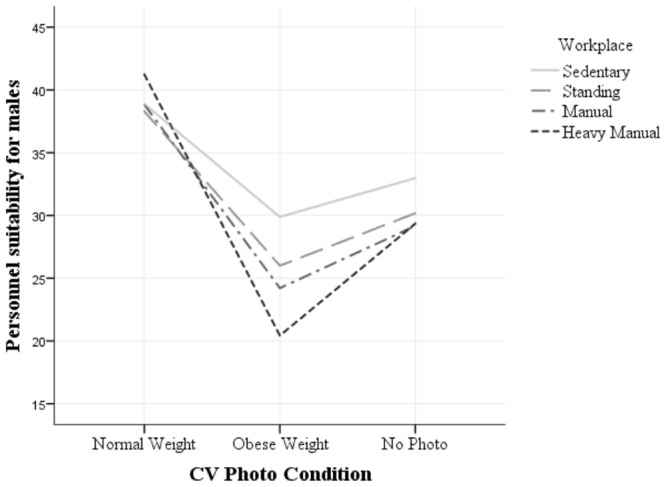
Three Way Interaction of Gender × Photo × Workplace (male).